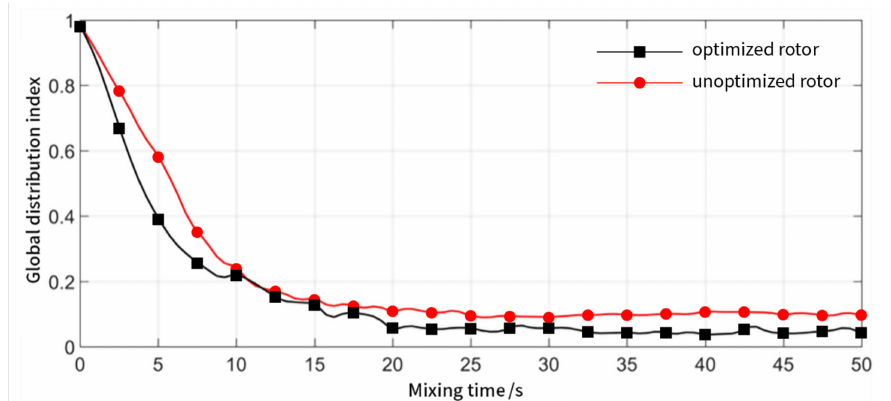
Figure 13. Global distribution index for the optimized rotor (black) and rotor before optimization (red) as a function of time.